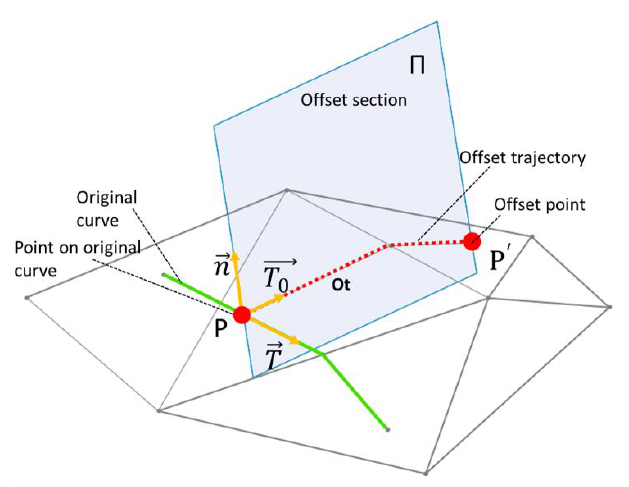
Figure 7. O ff set point generation on a triangular Figure 7. Offset point generation on a triangular mesh.